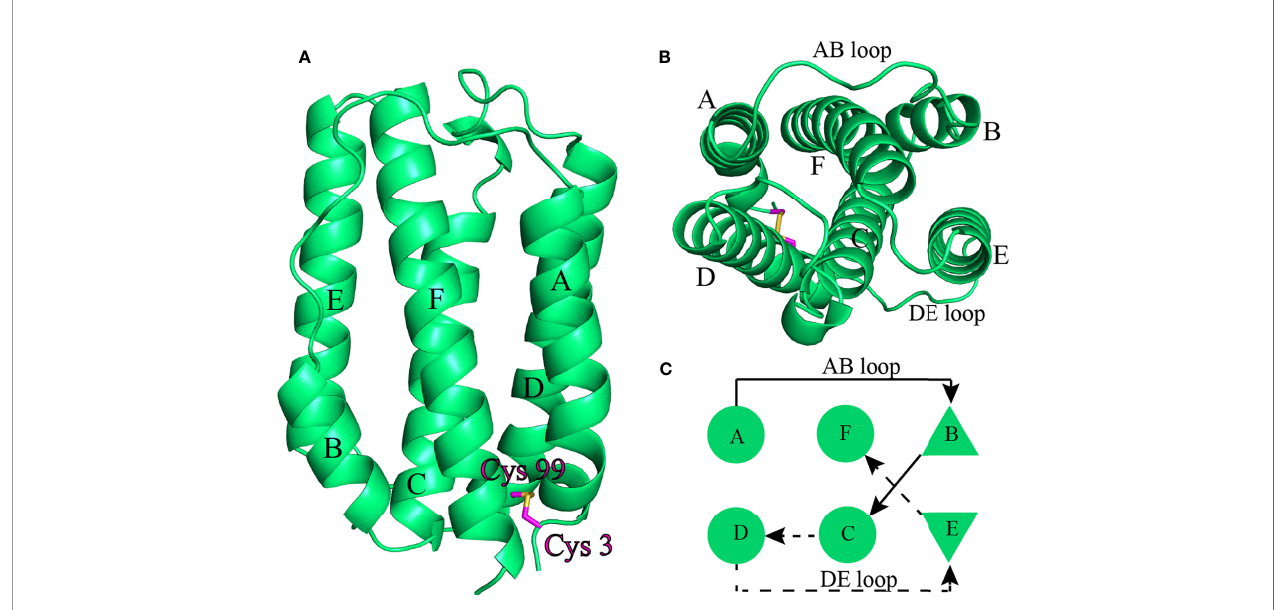
FIGURE 3 | The overall structure of Ci IFNa. The structure is shown in cartoon representation and colored in lime green. (A) Ribbon structure of dimer. (B, C) Ribbon structure (B) and schematic diagram (C) of monomer. The helix A – F, AB Loop, and DE loop are indicated. The disul fi de bond is shown in stick. Solid and broken arrows indicate front and behind positions,